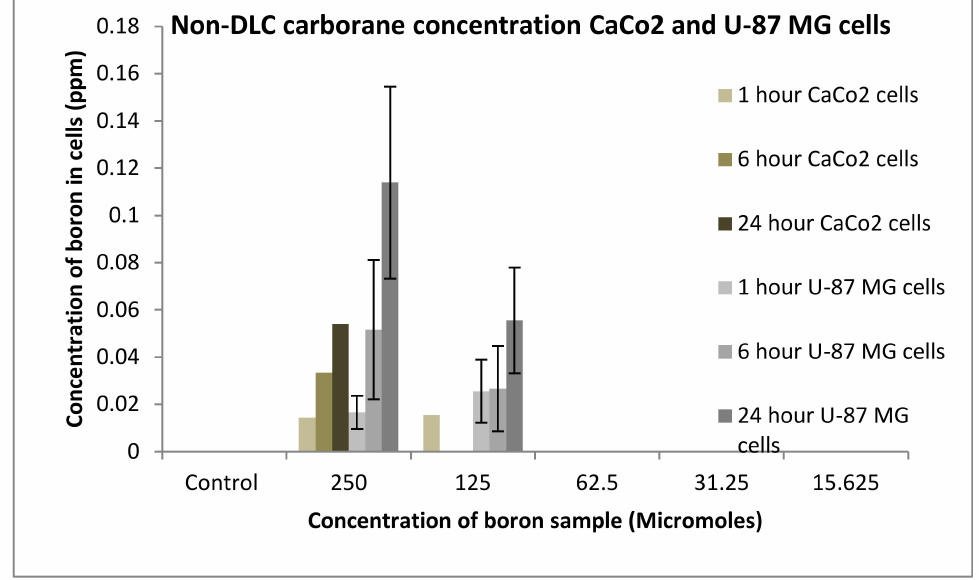
Figure 15. Uptake of boron for non-DLC containing carborane into CaCo2 and U87 MG cells after